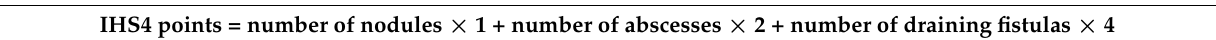
Table 2. International Hidradenitis Suppurativa Severity Score System (IHS4) [11]. Mild HS 3 or less than 3 points Moderate HS